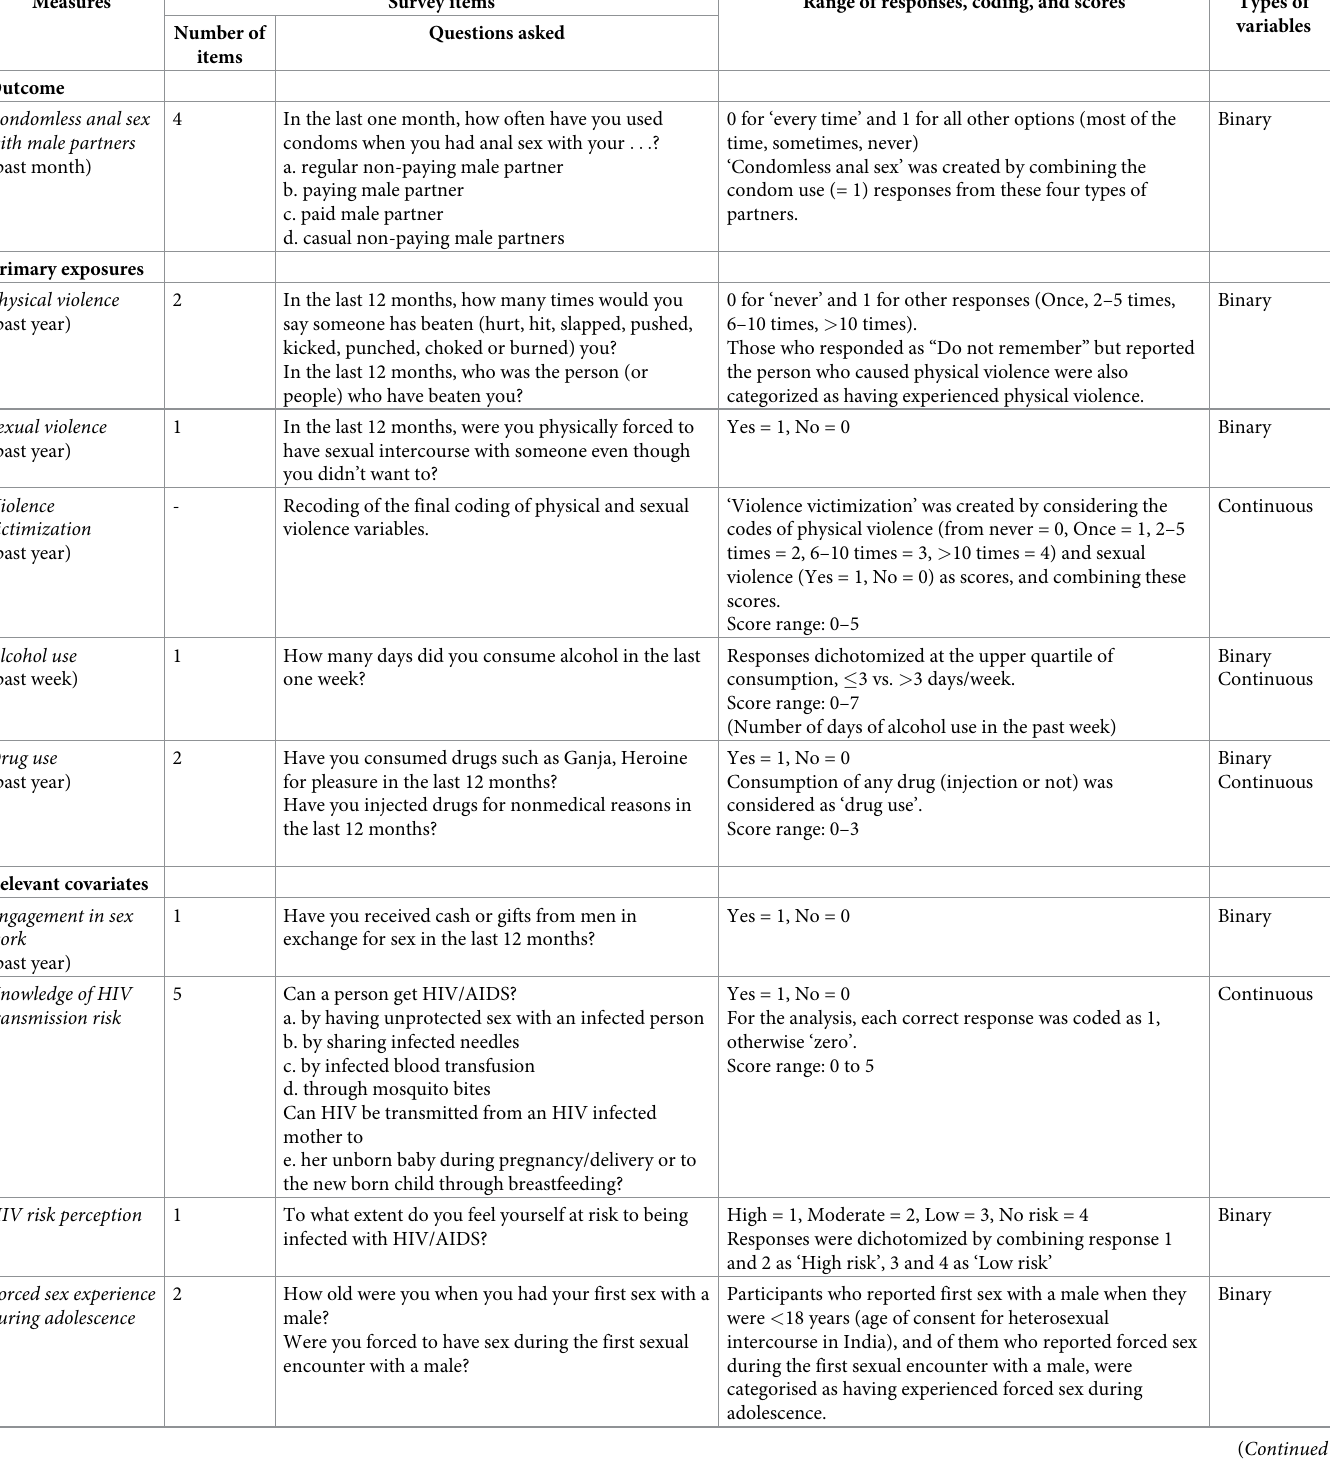
Table 1. Summary of key measures: Outcome, primary exposures, and other relevant covariates.